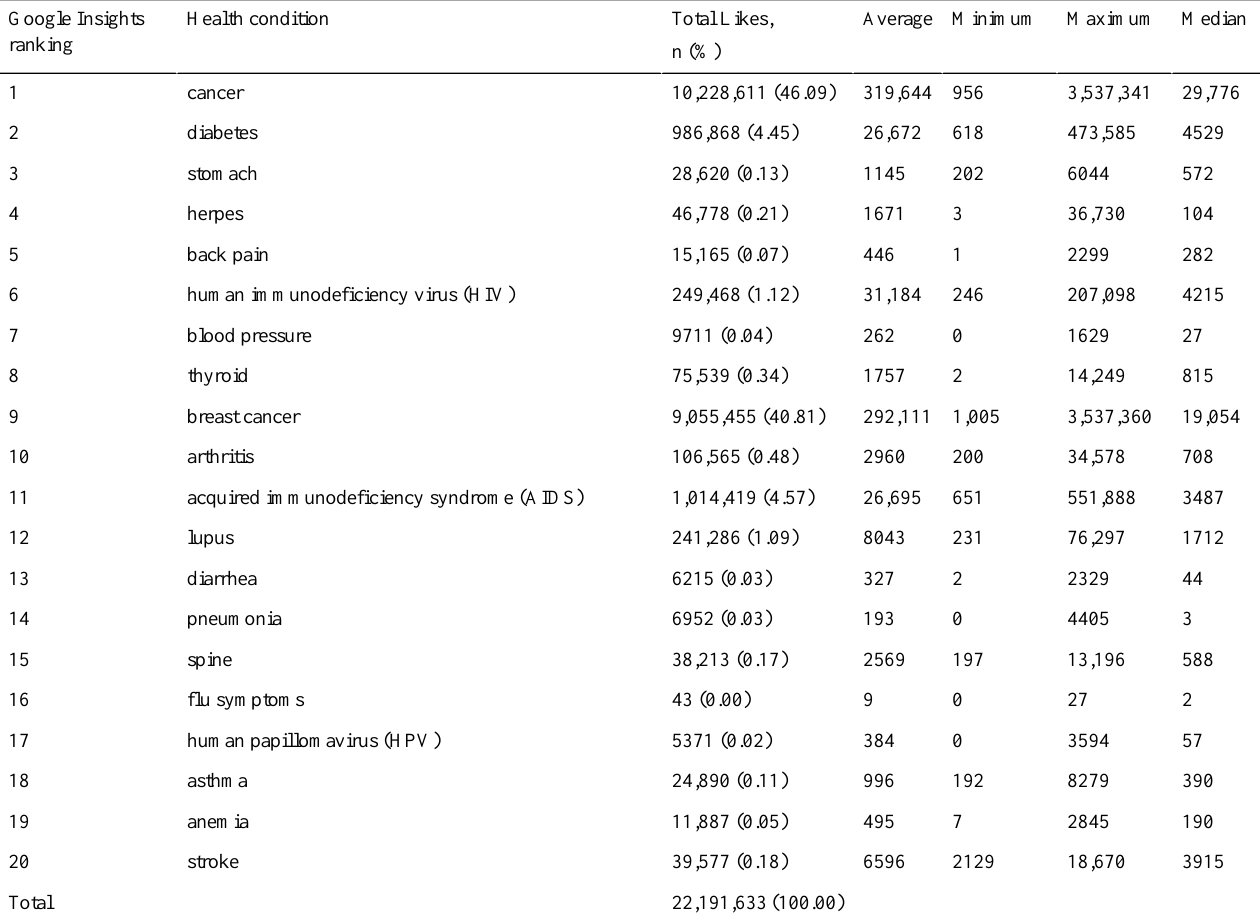
Table 6. Facebook “Likes” by health